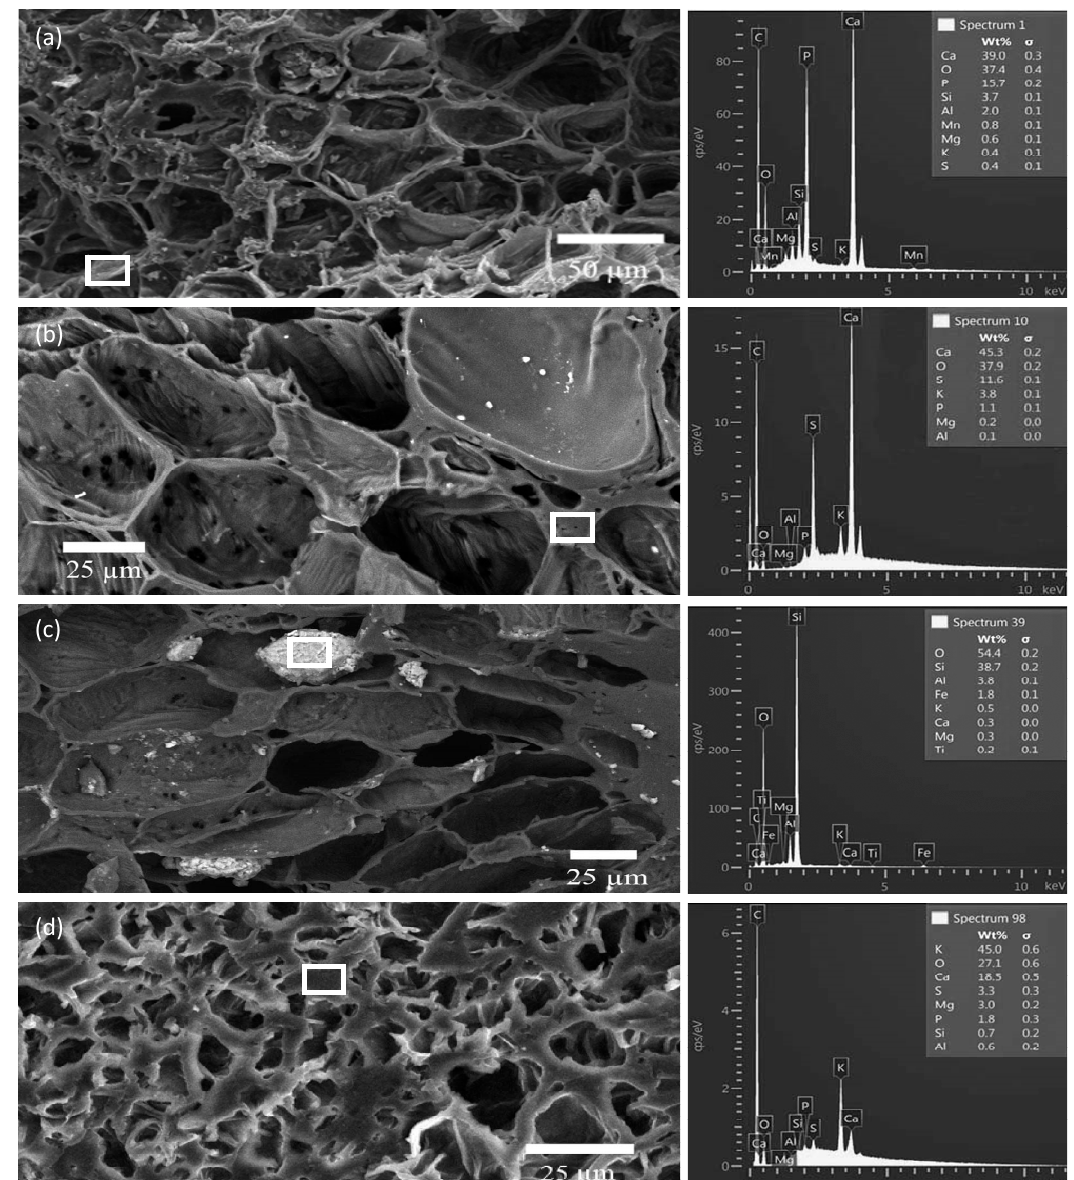
Figure 7. SEM images and spectra of particles and matrix fracture surfaces of pineapple peel biochar recovered from soil after 8 ( a ), 4 ( b ), 8 ( c ) and 1 ( d ) months. EDS spectra and analyses of the indicated mineral particles ( c ) or matrix ( a , b , d ) are shown.